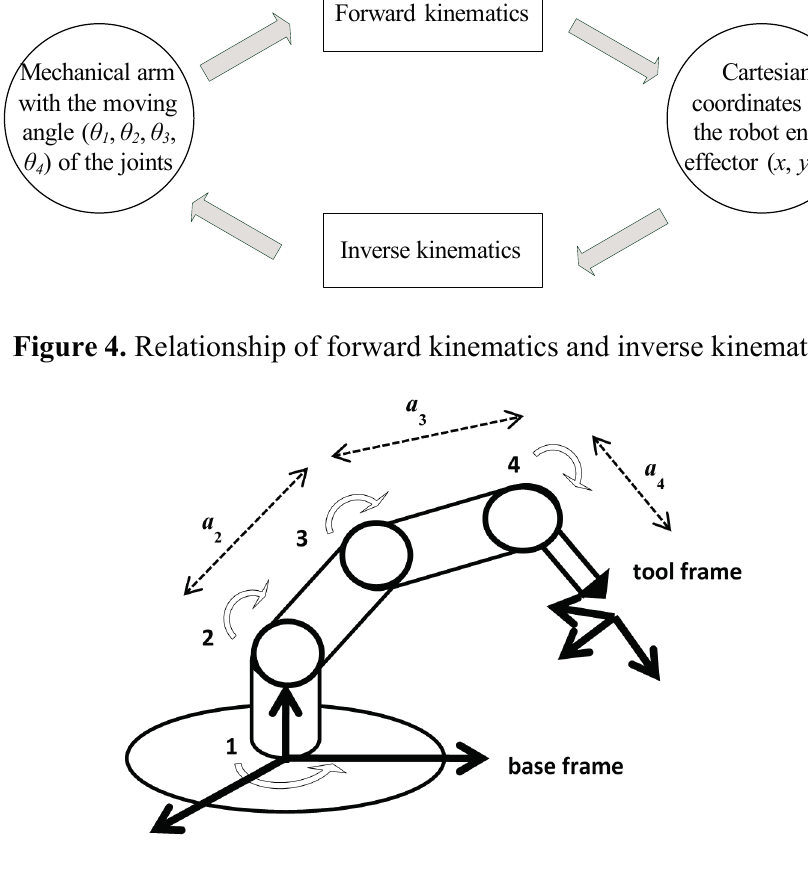
Figure 5. Kinematic model of robotic arm with four degrees of